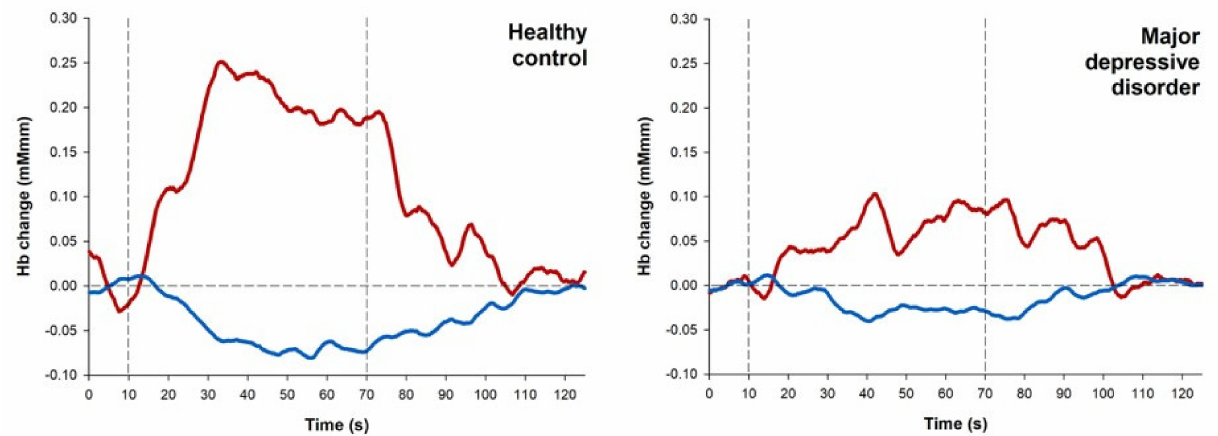
Figure 4. Mean oxy- and deoxy-Hb waveforms at Channel 38. Vertical dotted lines indicate the start and end of the task